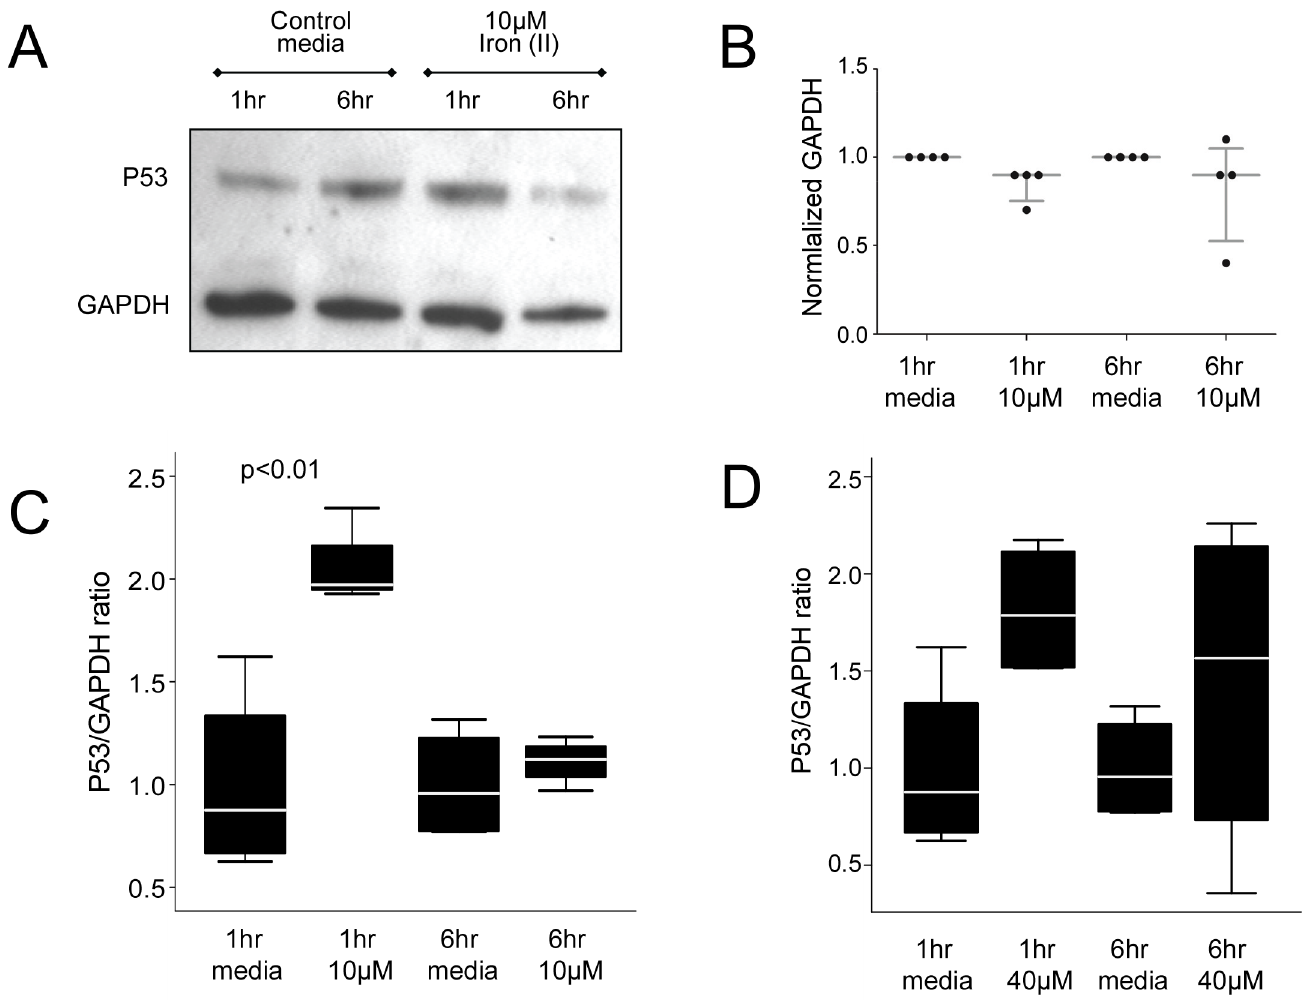
Fig 6. P53 protein expression. A) Representative Western blot of p53 and GAPDH expression in HUVEC after treatment for 1 or 6 hours with fresh media or iron (II) citrate. (Original images supplied.) B) Quantifications of GAPDH (median and interquartile range displayed). C) P53 expression relative to GAPDH, p value calculated by Dunn ’ s test post Kruskal Wallis. Note in all four experiments, p53/GAPDH increased at 1 hour (minimum 1.5 fold; mean 2.1 [95% confidence intervals 1.8, 2.4] fold), and returned to baseline by 6 hours. D) P53/GAPDH protein changes in HUVEC treated with 40 μ M iron (II) citrate. Box plots demonstrate median, interquartile range, and two standard